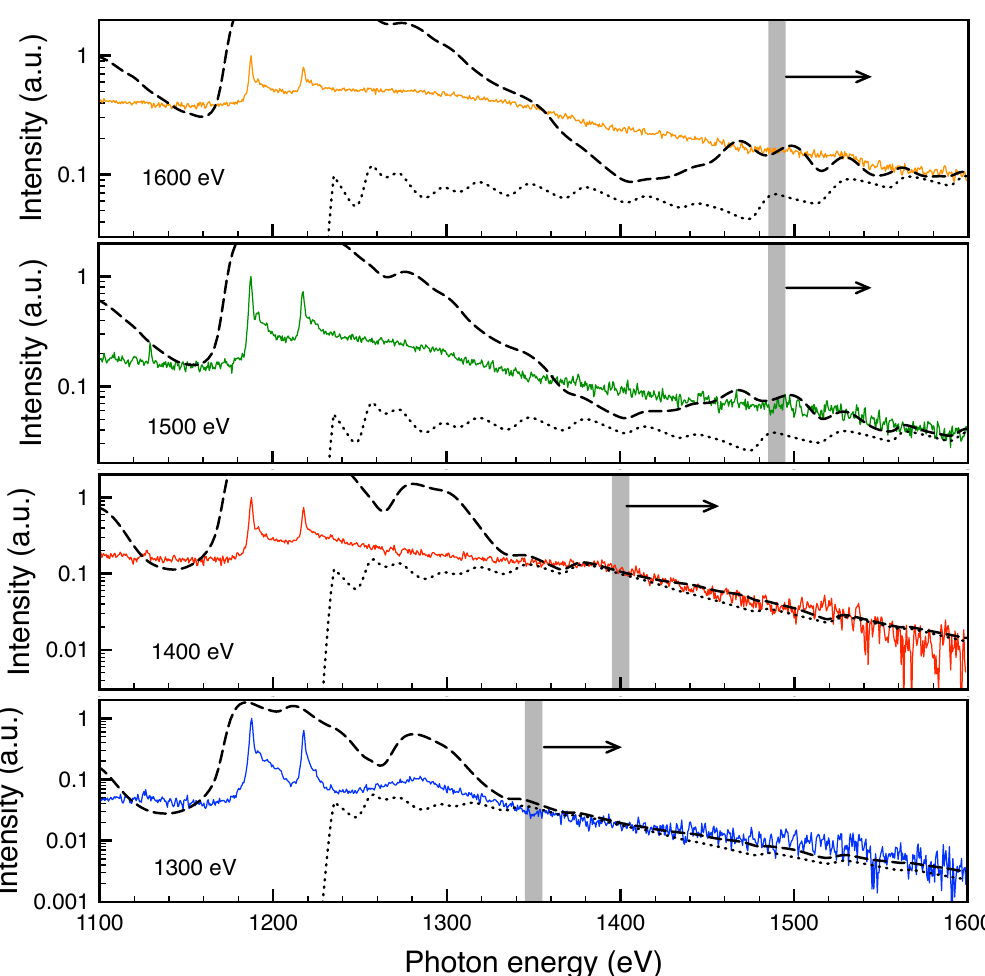
Figure 5. Comparison between the experimental (solid, colored) and simulated spectra (dashed) for the four different XFEL photon energies. The dotted lines correspond to the bound-free contribution to the overall simulated spectra. The gray area indicates the photon energy above which the emission has been used to estimate the temperature. For the 1500 and 1600eV cases, the bound-free emission presents several edges from the different charge states in the plasma, which makes getting a temperature from the slope more subject to error. In all cases the simulations agree with the data in the regions above the gray areas, whereas the bound-bound emission is poorly reproduced. The experimental spectra for 1300, 1400, 1500 and 1600eV have been averaged over 102, 116, 156 and 122 shots